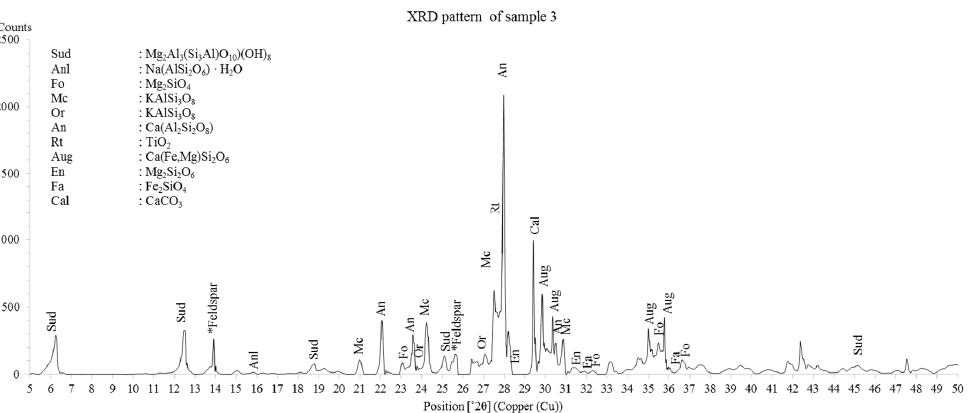
Figure 5. XRD analysis sample 2 of the Segamat basalt (Chl: chlorite, Sud: sudoite, *Feldspar: common feldspar group peak, Anl: analcime, Afs: alkali feldspar, Mc: microcline, An: anorthite, Fo: forsterite,